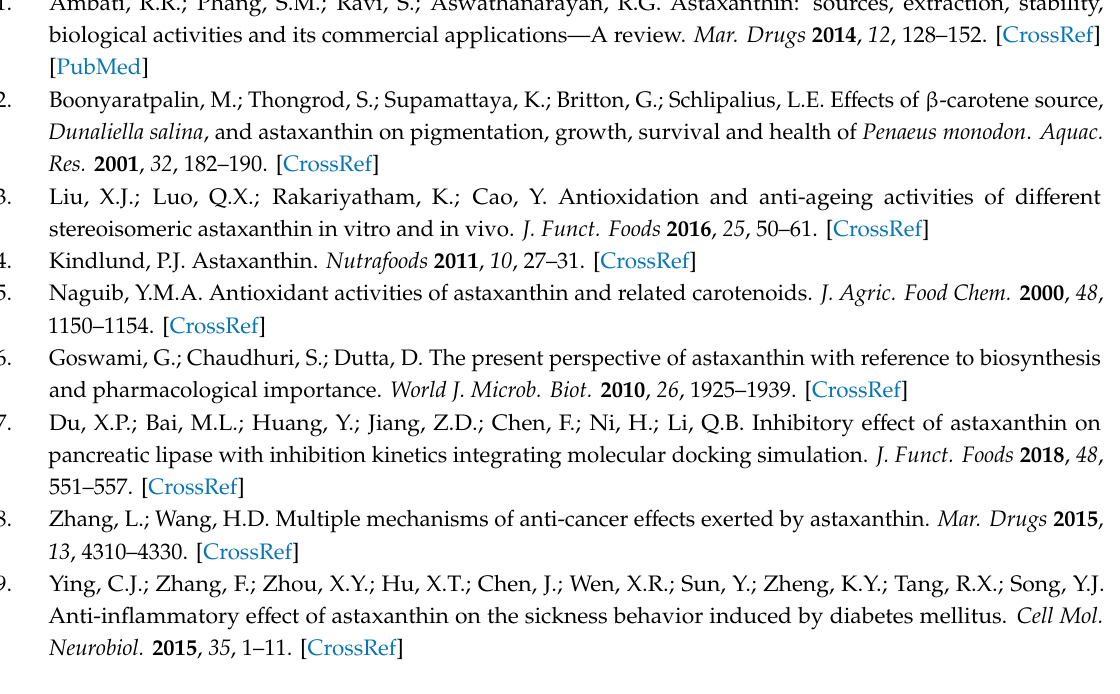
Figure S1: The calibration curves